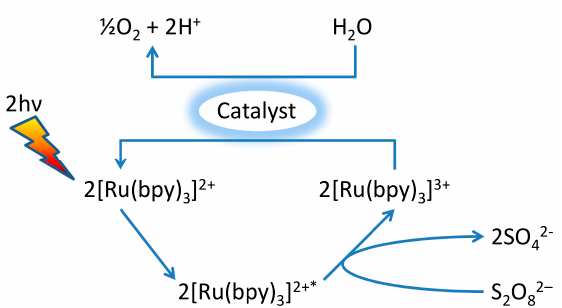
Scheme 1. General functioning mechanism of the light driven water oxidation